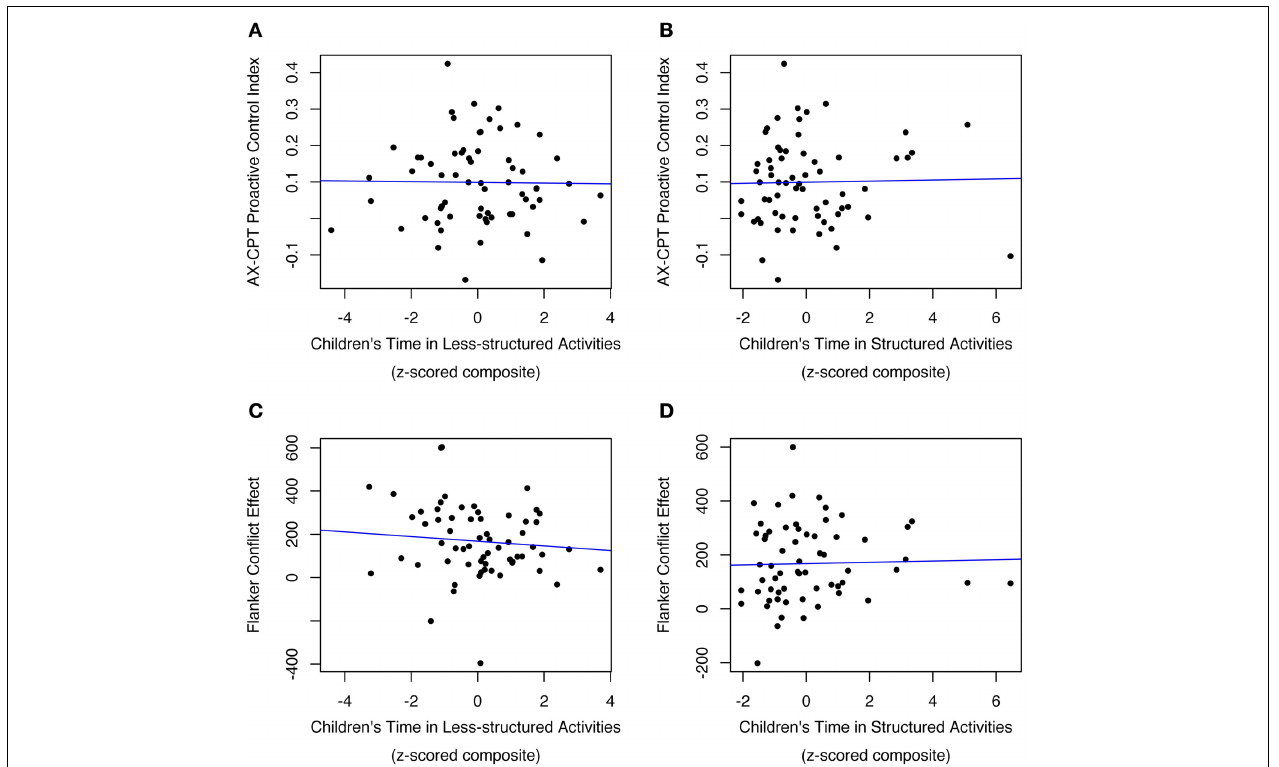
FIGURE 3 | Children’s externally-driven EF (as measured in AX-CPT and Flanker) was not predicted by their time spent in either less-structured activities (A,C) or structured activities (B,D). Outlying observations have been excluded [ N = 1 in (A,B) ; N = 2 in (C,D)